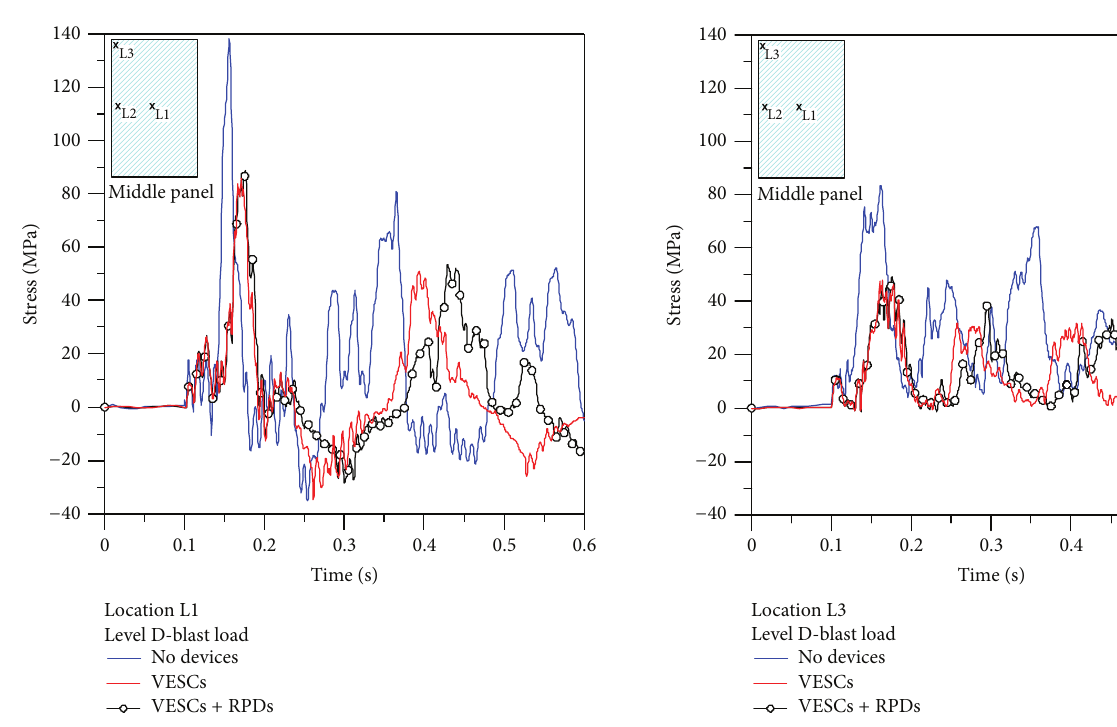
Figure 9: Tensile stresses in the middle glass panel as a function of time (ABAQUS). Location L3.